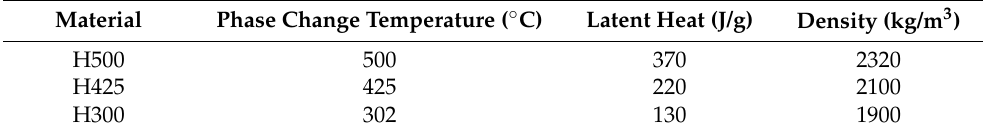
Table 5. Phase-change material properties